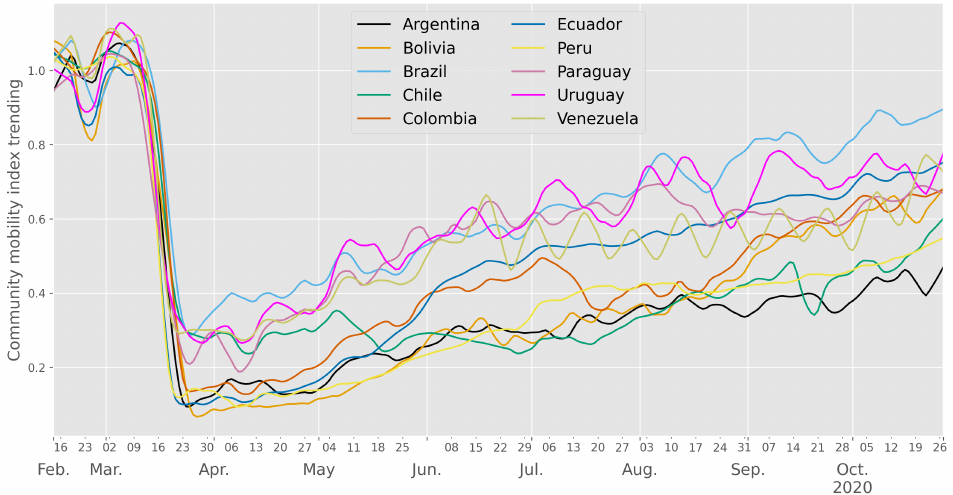
Figure 6. Evolution of the community mobility index in South America, from 15 February to 27 October 2020. Source of basic data: Covid-19 Community Mobility Reports,